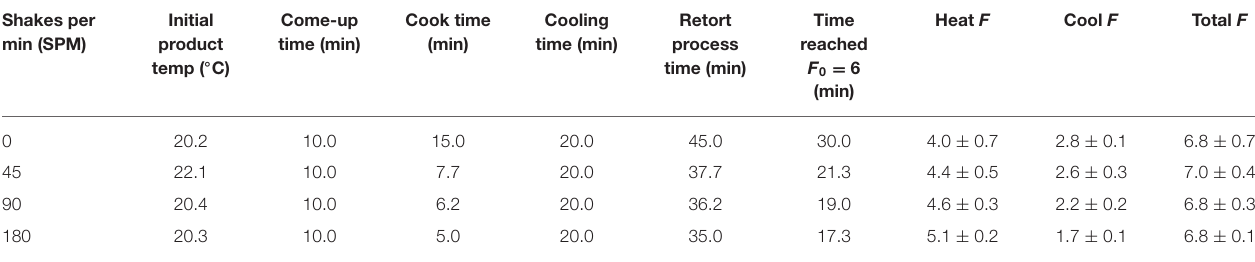
TABLE 1 | Retort settings and accumulated F 0 values at 0, 45, 90, and 180 SPM of retorted Louisiana Gulf Coast (LGC) brown shrimp using the general formula method 1,2 . Shakes per Initial min (SPM)